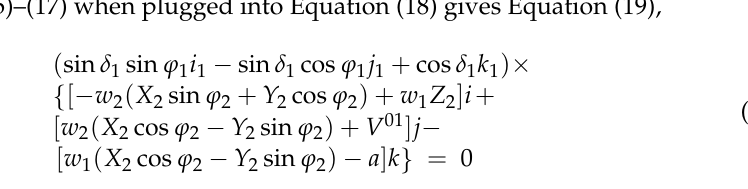
Figure 7. The schematic diagram of the research flow. 5. Load Distribution Model It is well-known that cylinder gears need to be modified when a high load is carried. Figure 2 shows the correct method to alter the cylinder gear. This is always true when the meshing number is not more than two [17]. In some applications, such as window lift, three to four teeth carry the load in the steel worm and plastic helical gear train. Here, the working torque is further lowered than the maximum torque (stall torque). During the life test at a high temperature (~90 °C), the plastic helical gear is easily broken when maximum torque is applied.